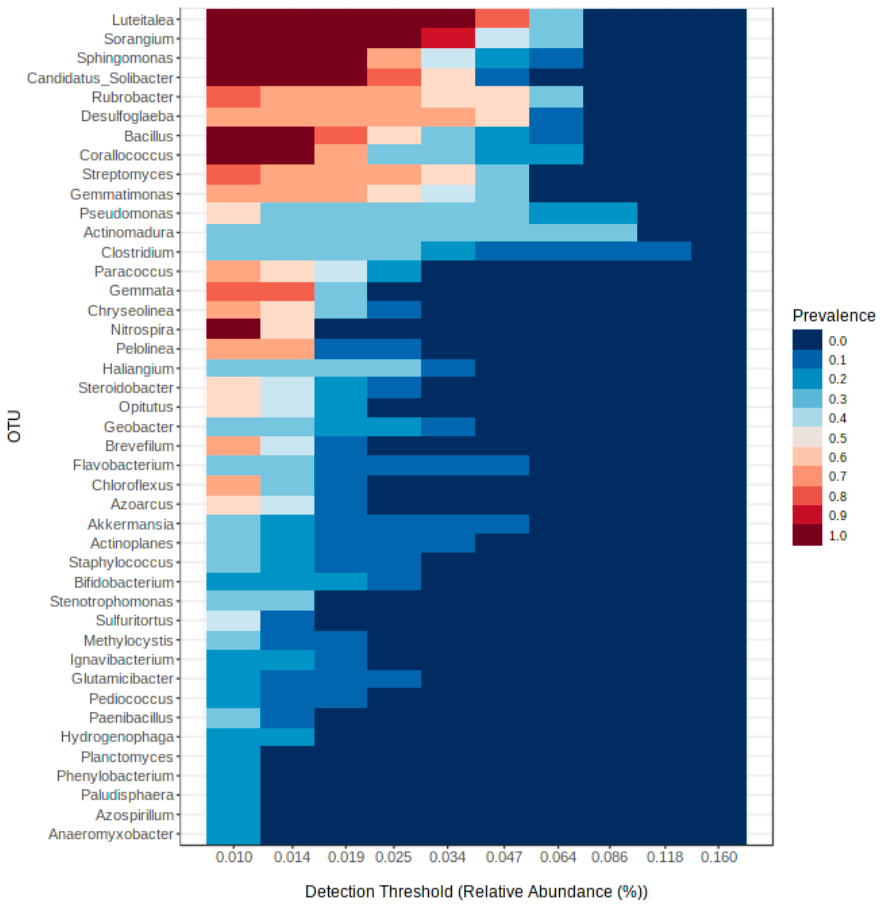
Figure 5. Heat map showing the core bacterial microbiome of rice rhizosphere soil of three different rice planting systems under saline conditions.